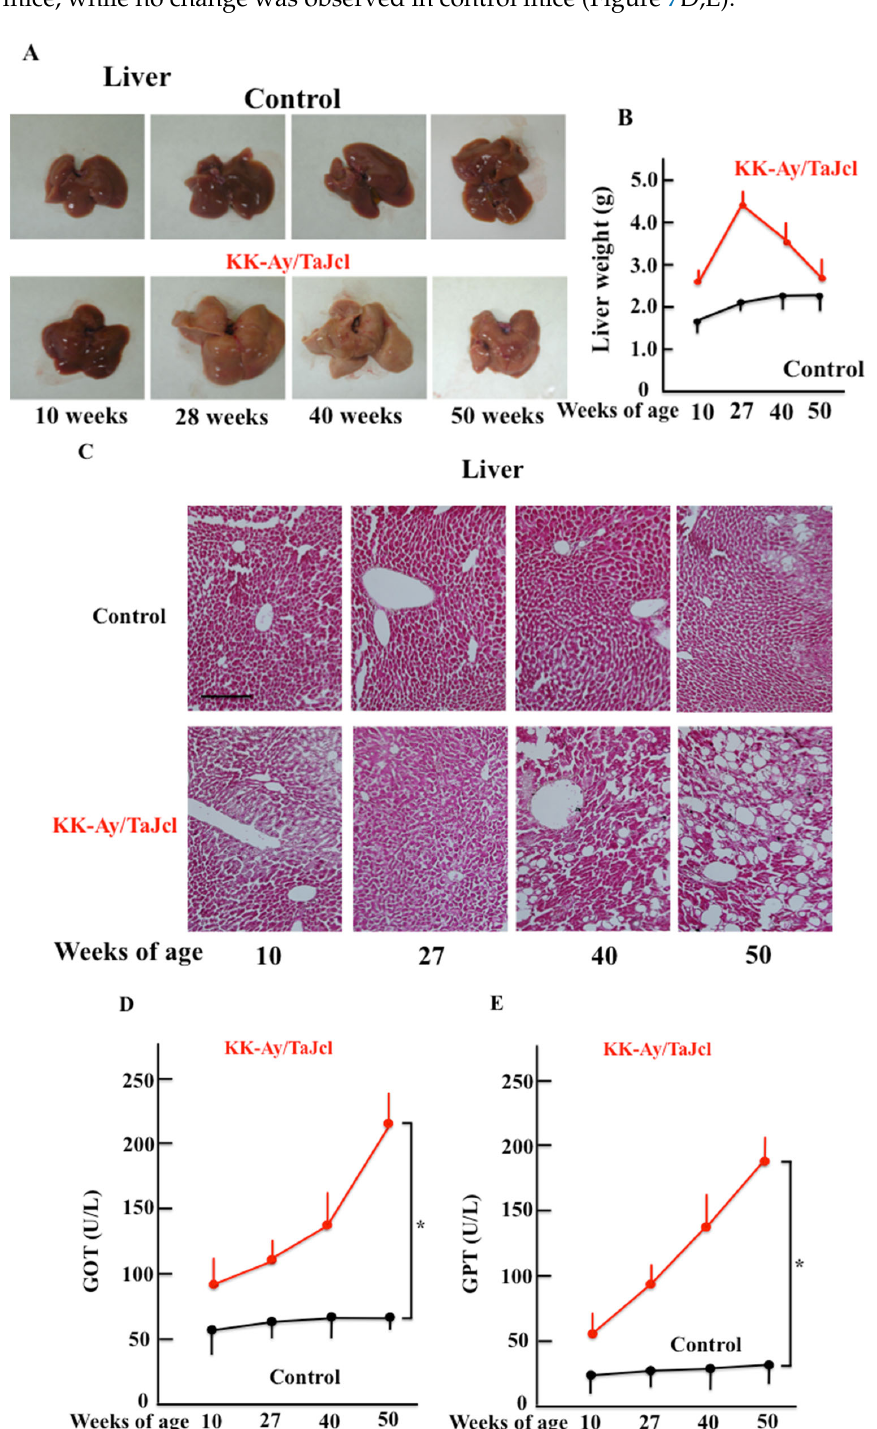
Figure 6. Effect of aging on liver condition ( A ), liver weight ( B ), and hematoxylin–eosin staining ( C ); and blood levels of GOT ( D ) and GPT ( E ) in the dorsal skin of KK-Ay/TaJcl mice. The data show one representative experiment performed on five animals. Scale bar = 100 μ m. Values are expressed as mean ± SD derived from five animals. * p < 0.05. Control: C57BL/6j mice.